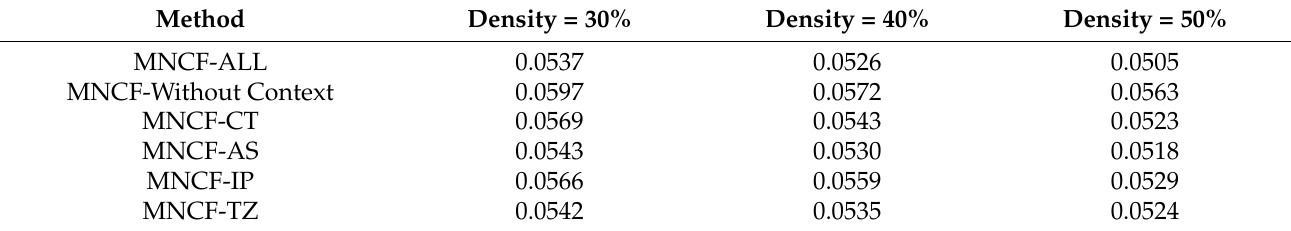
Table 3. Performance of RMSE with Different Contexts (MaxBlockBack = 12, MaxRTT = 1000).